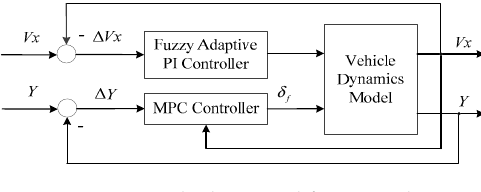
Figure 6. Vehicle control framework.